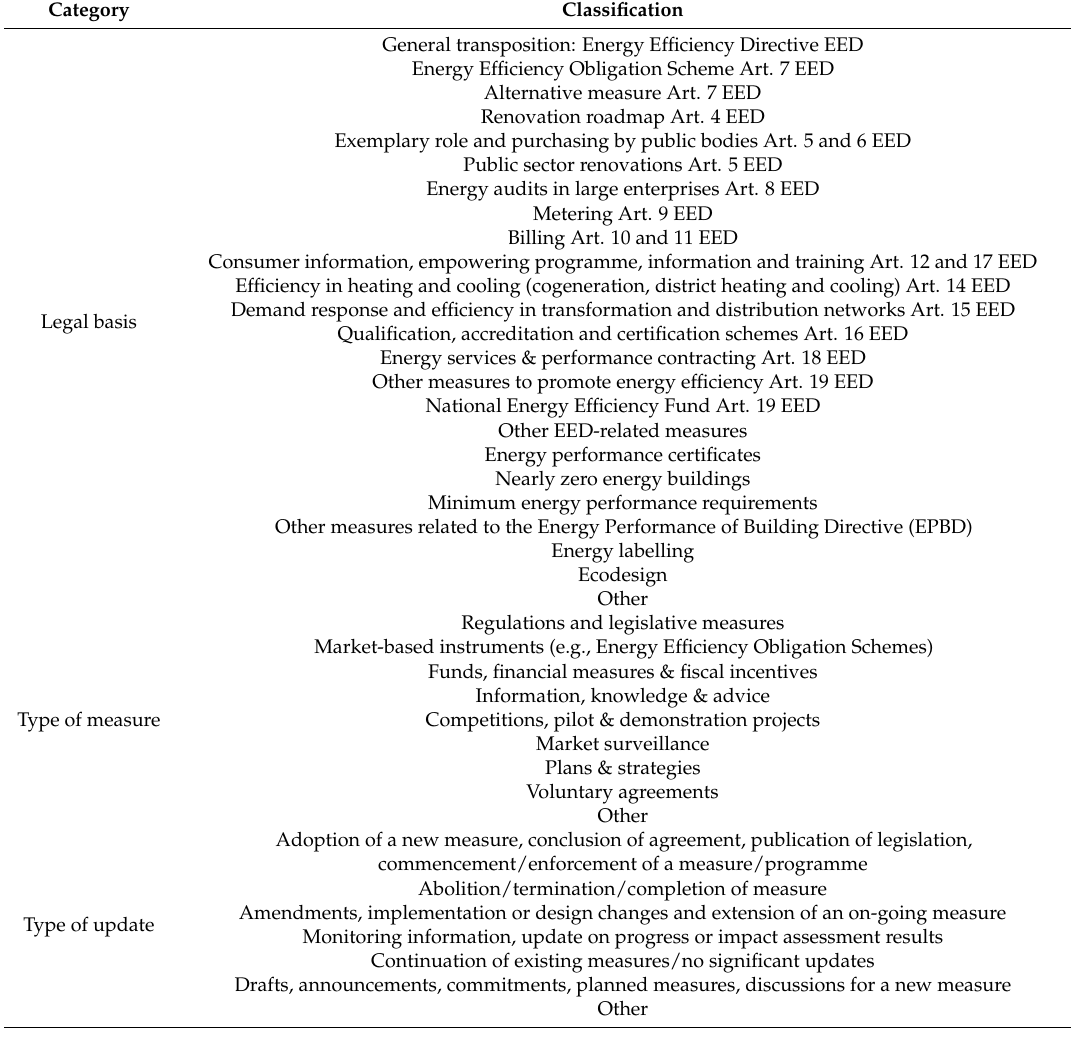
Table 4. Categories used to classify the measure updates within the harmonized